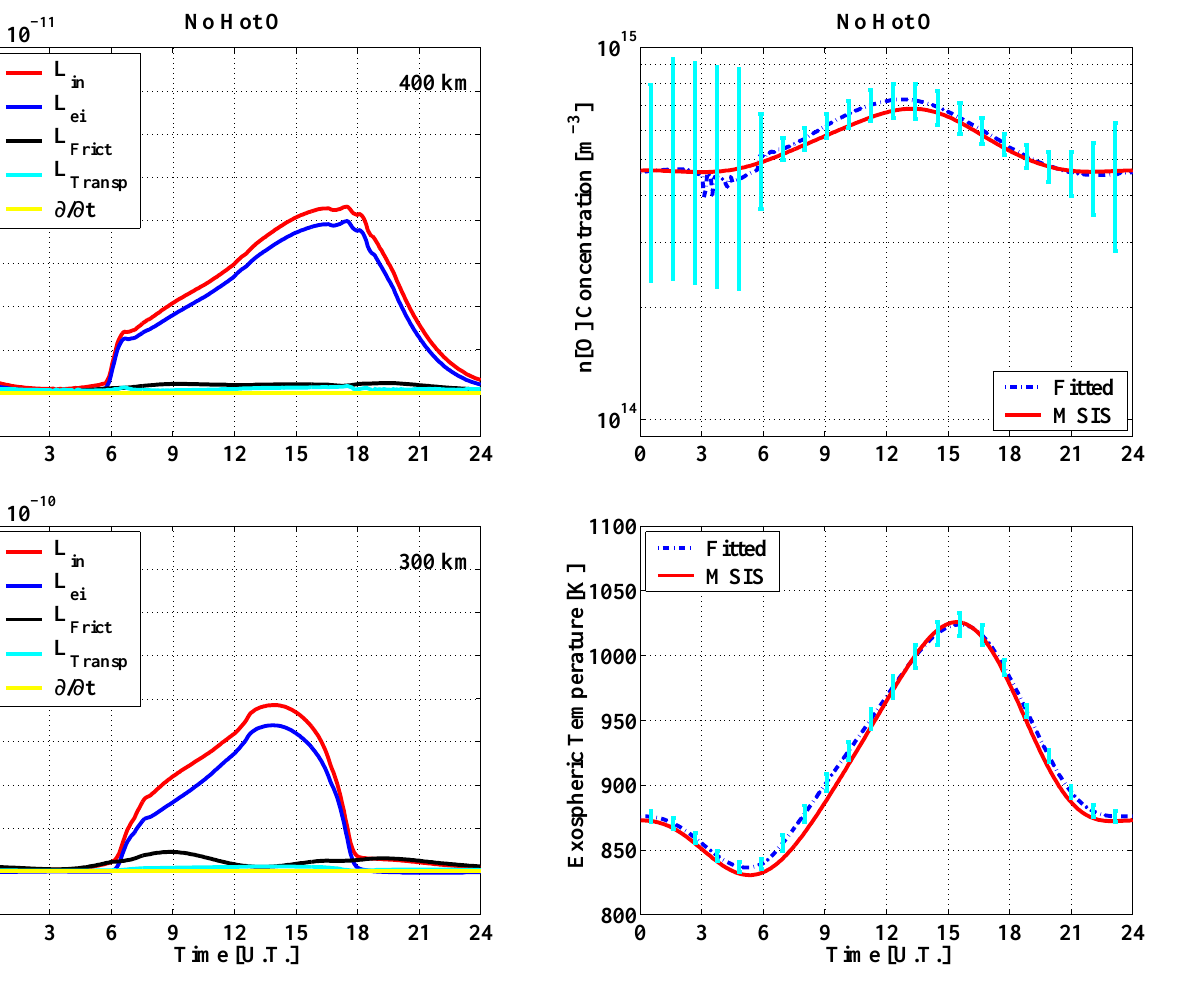
Fig. 2. Energy equation terms (see text and Eq. 7) extracted from the TRANSCAR outputs at 400 km (top panel) and 300 km (bottom panel) altitudes.